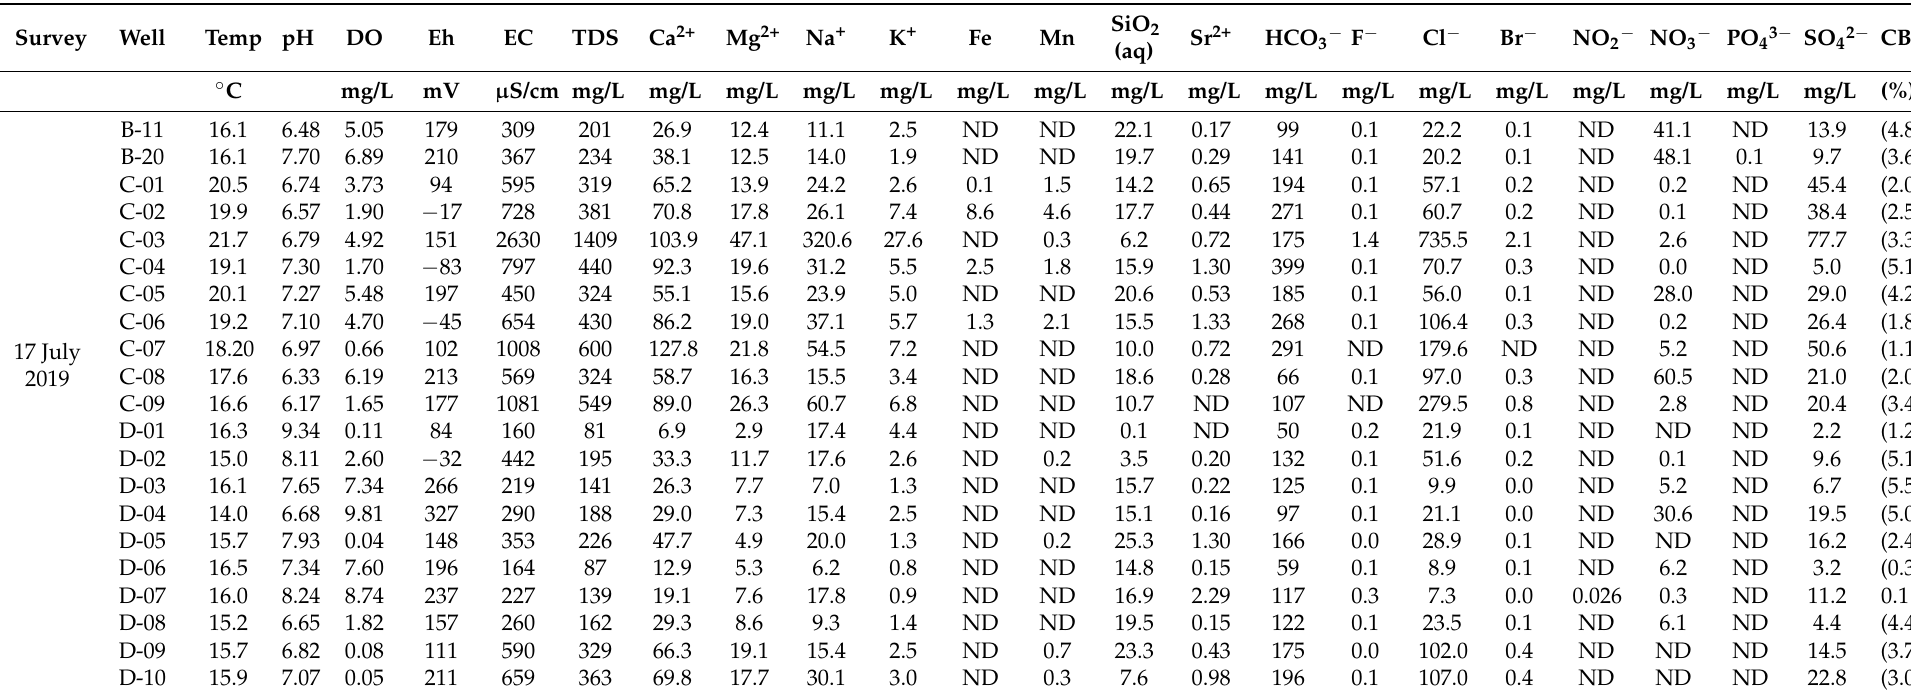
Table 3. Hydrochemical analysis results of